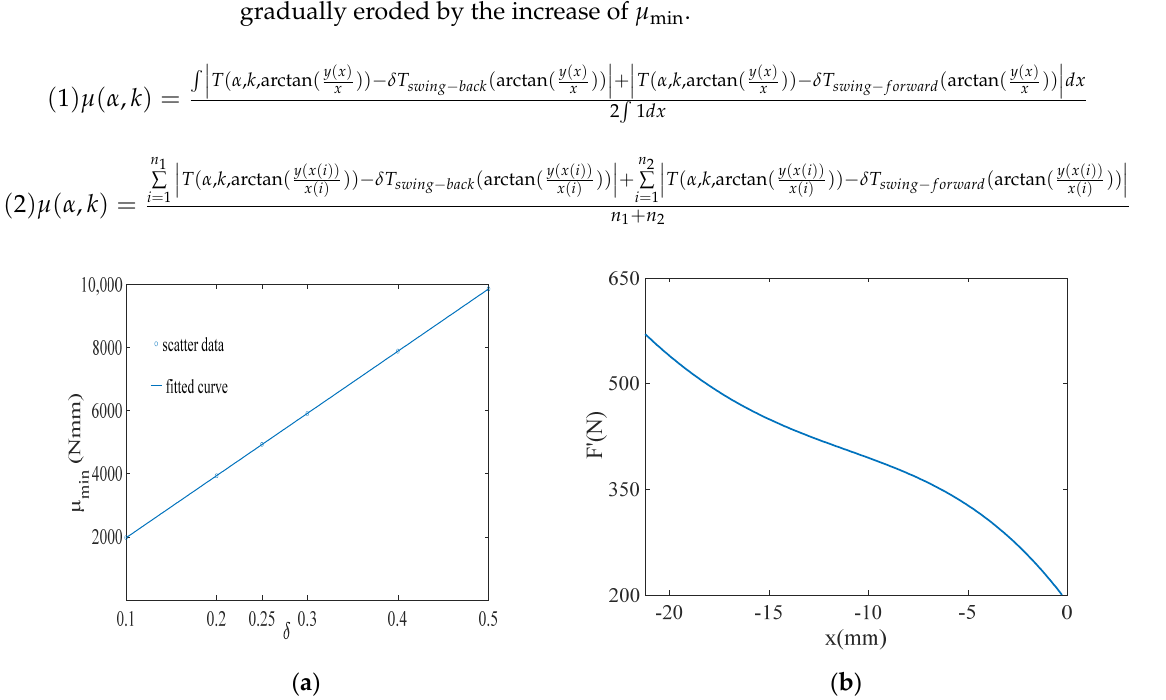
). The elastic force